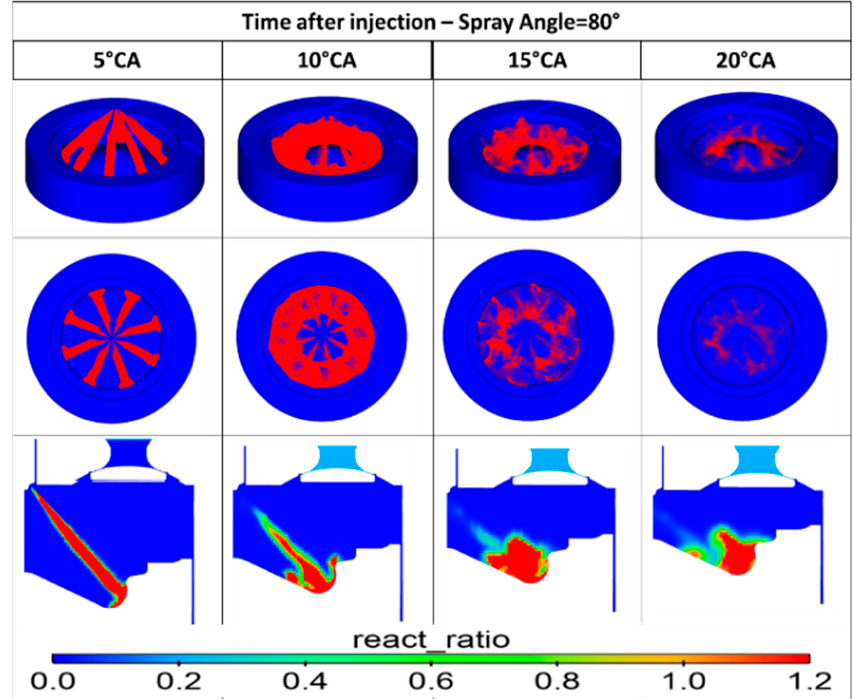
Figure 33. For an SIA of 80°, spray penetration in oblique side and top views and RER contour plot in a planar section through the cylinder axis and a spray axis. For various SIAs of 140°, 130°, 120°, 100°, and 80°, in-cylinder temperature and NO x